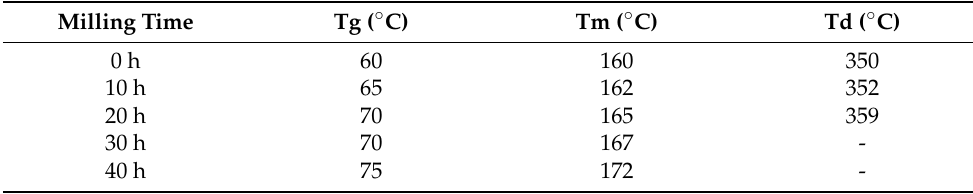
Figure 9. DSC of coconut shell nano-biocomposite for various milling times with 30 wt.% of PP composition. Table 7. DSC data of coconut shell biocomposite for various milling times.